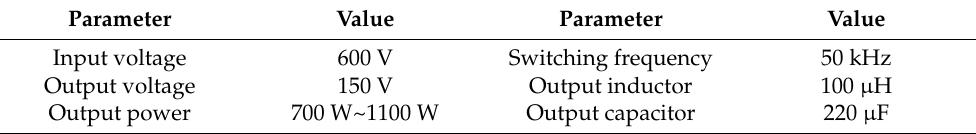
Figure 14. Efficiency of the buck converter with DC-side snubbers. Table 3. Efficiency-tested conditions of the buck